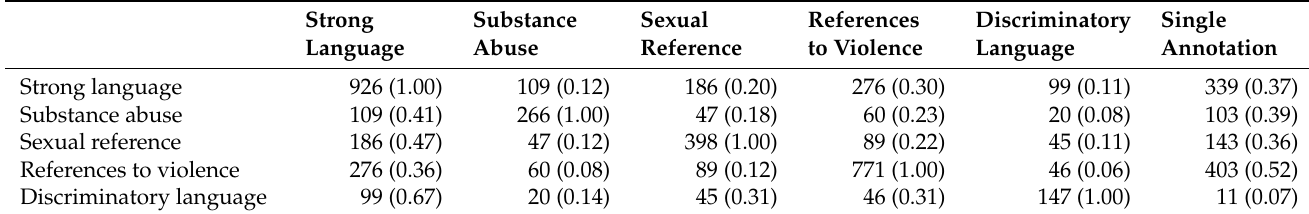
row category are reported between round brackets. “Single annotation” refers to the counts of the cases where the row category does not co-occur with any other